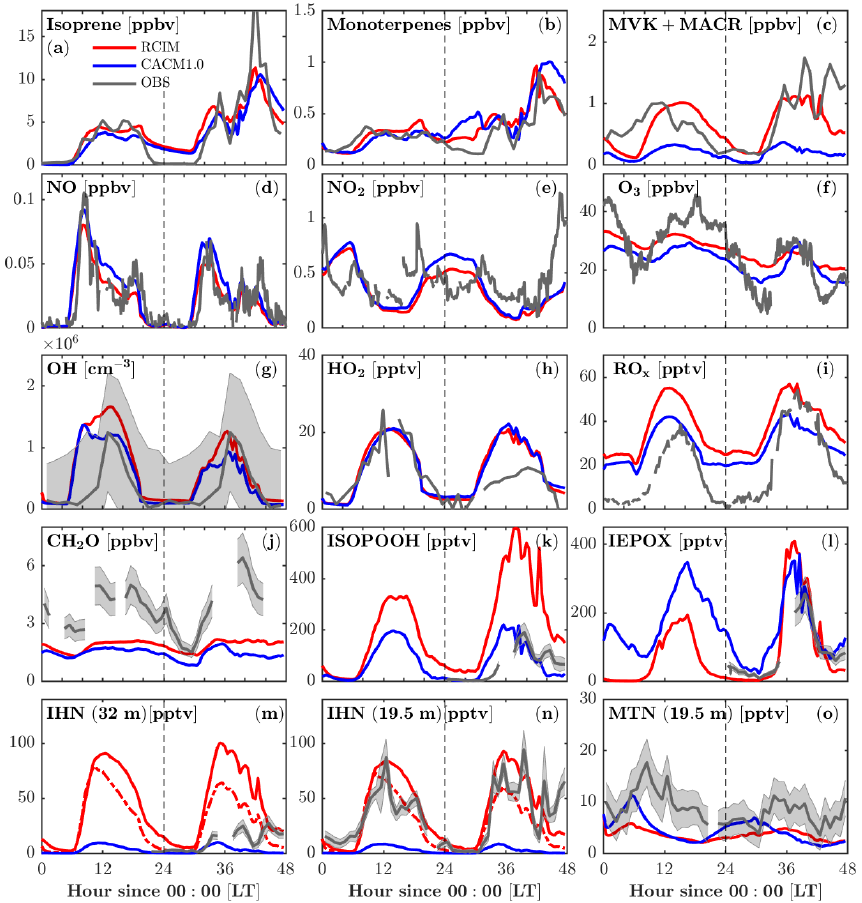
Figure 4. Comparison of FORCAsT 2.0 with the RCIM (red) and CACM1.0 (blue) mechanisms against observations in and above the canopy (heights noted). Gas-phase concentrations are evaluated versus observations (grey), including isoprene (34m), monoterpenes (34m), methyl vinyl ketone + methacrolein (MVK + MACR, 34m), nitric oxide (NO, 29m), nitrogen dioxide (NO 2 , 29m), ozone (O 3 , 6m), hydroxyl radi- cals (OH, 32m), hydroperoxy radicals (HO 2 , 32m), total peroxy radicals (RO x , 30m), formaldehyde (CH 2 O, 21m), hydroxy hydroperoxide isomers (1,2-ISOPOOH + 4,3-ISOPOOH, 32m), epoxydiol isomers ( cis -IEPOX + rans -IEPOX, 32m), isoprene hydroxy nitrates (1,2-IHN + 4,3-IHN, 32m), IHN (19.5m), and monoterpene hydroxy nitrates (MTN, 19.5m) in sequence from (a) to (o) . Grey shaded areas denote 1 standard deviation of the data when available. Instrumental information is in Table 4. The red dashed lines in (m) and (n) denote modeled IHN with a hydrolysis loss rate of 4 × 10 5 Matm − 1 s − 1 for